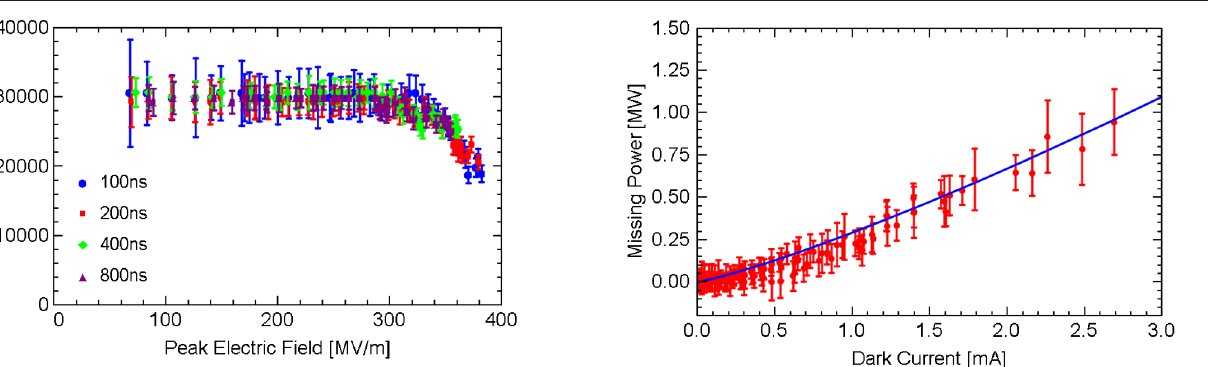
FIG. 5. Measured (red) and simulated (blue) missing power in the accelerating cavity versus the measured dark current magni- tude for rf pulse lengths 100 – 800 ns. The missing power is the difference between what we measured as the power lost to the cavity walls, and what would have been lost to the walls in the linear model. The simulation of power being lost to dark currents is consistent with the presented